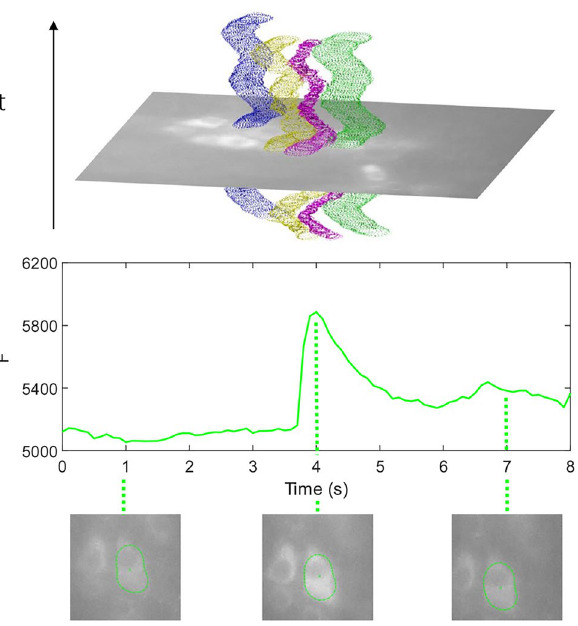
Figure 6. Contours of multiple cells and cell movement (top). Pixel intensity signal from the one tracked cell in the top panel and the contour appearance at multiple time points before, during and after a peak in Ca 2+ activity.